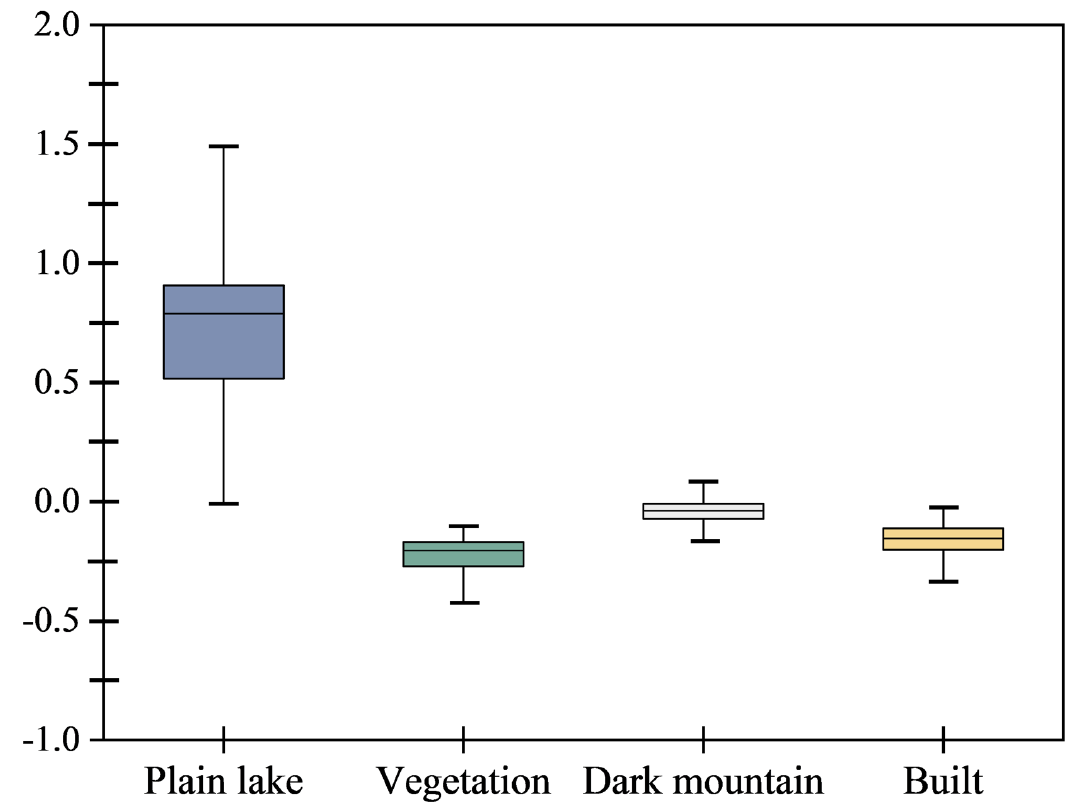
Figure 5. UNWI distributions of pure pixels of major land cover types.